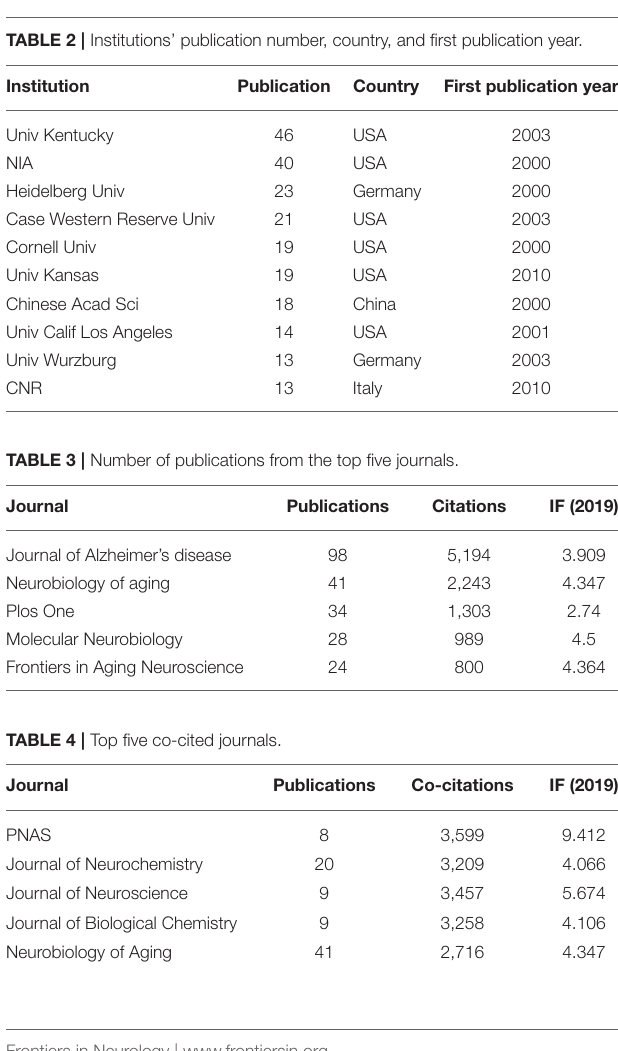
TABLE 2 | Institutions’ publication number, country, and first publication year.